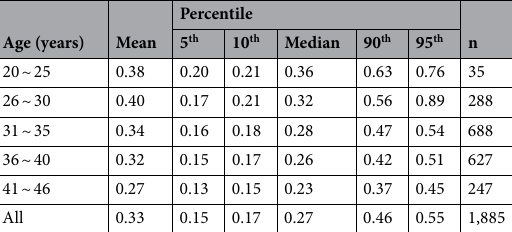
Table 4. Serum testosterone level distribution (ng/mL) based on